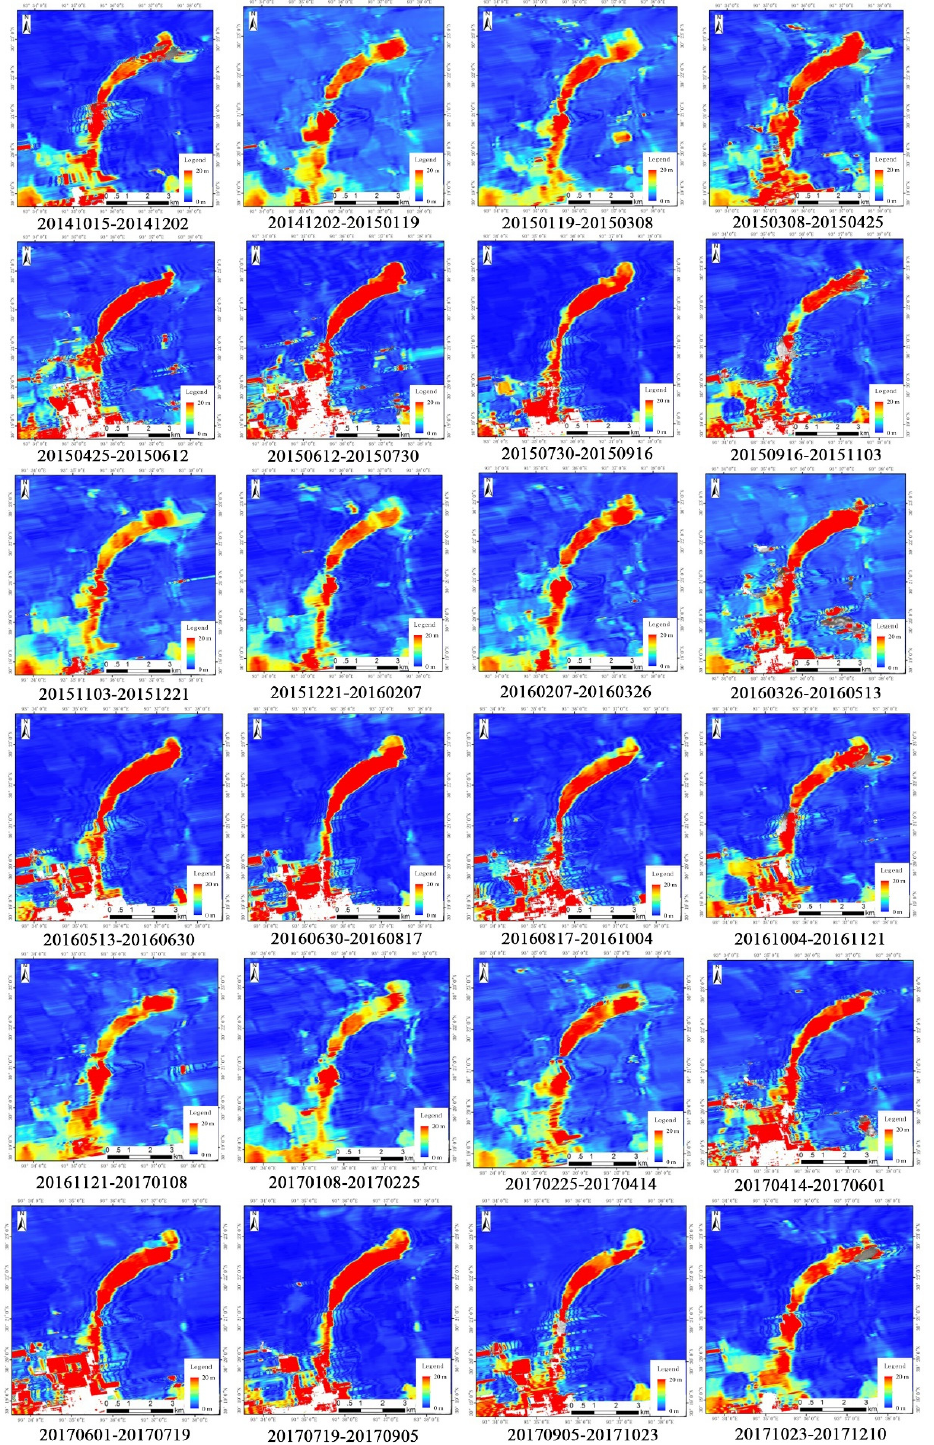
Figure 4. Movement distribution of the Yiga Glacier between 15 October 2014 and 10 December 2017.